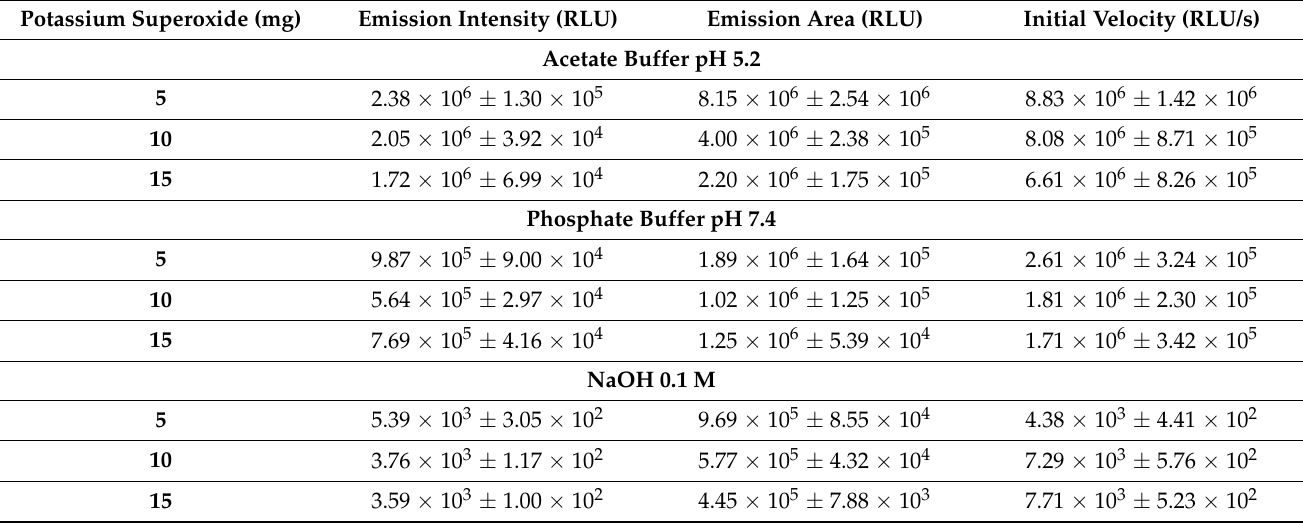
Table 1. Light-emission intensity maxima (in RLU), area of emitted light (in RLU), and initial velocities (in RLU/s) of the CL reactions of MeOBr-Cla in aqueous solutions with the addition of either sodium acetate buffer pH 5.2 (1%), phosphate buffer pH 7.4 (75 mM), or NaOH (0.1 M). Measurements were performed with different amounts of potassium superoxide (5–15 mg) as the superoxide anion source. Assays were performed for a final volume of 500 µ L and a MeOBr-Cla concentration of 5 µ